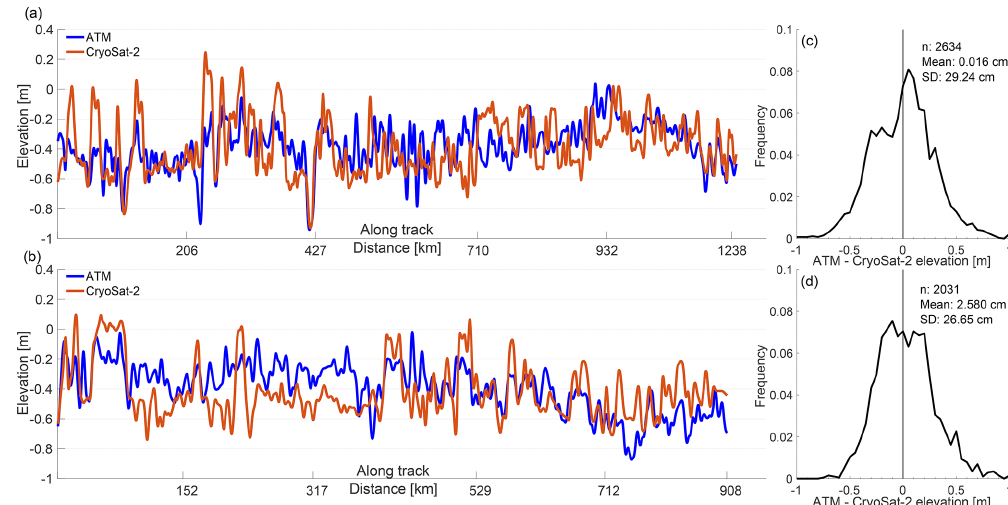
Figure 7. Surface (air–snow interface) elevation profiles of Operation IceBridge ATM (blue) and CryoSat-2 (orange) from the October 2011 (a) and November 2012 (b) campaigns. Frequency distributions of the elevation difference (ATM – CryoSat-2) along the 2011 (c) and 2012 (d) profiles are also shown. The mode of the differences is 0.025m in 2011 and − 0 . 24m in 2012. The 2011 profile contains measurements from (lat, long) -63.99, -45.11 to -75.04, -49.33 while the 2012 profile contains measurements from -66.14, -43.31 to -74.25, -46.46.